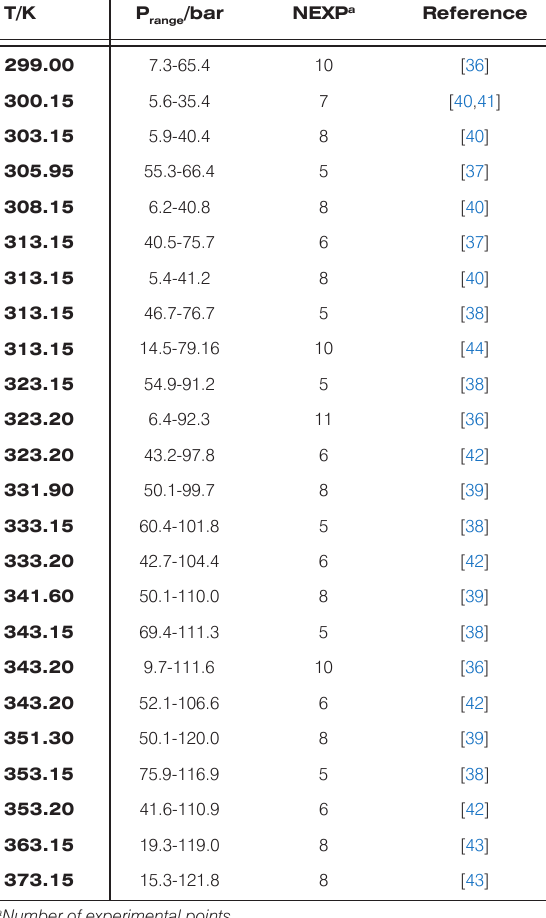
Table 1. Literature experimental data for the carbon dioxide + 2-methyl-2-propanol binary system. T/K P /bar NEXP a range